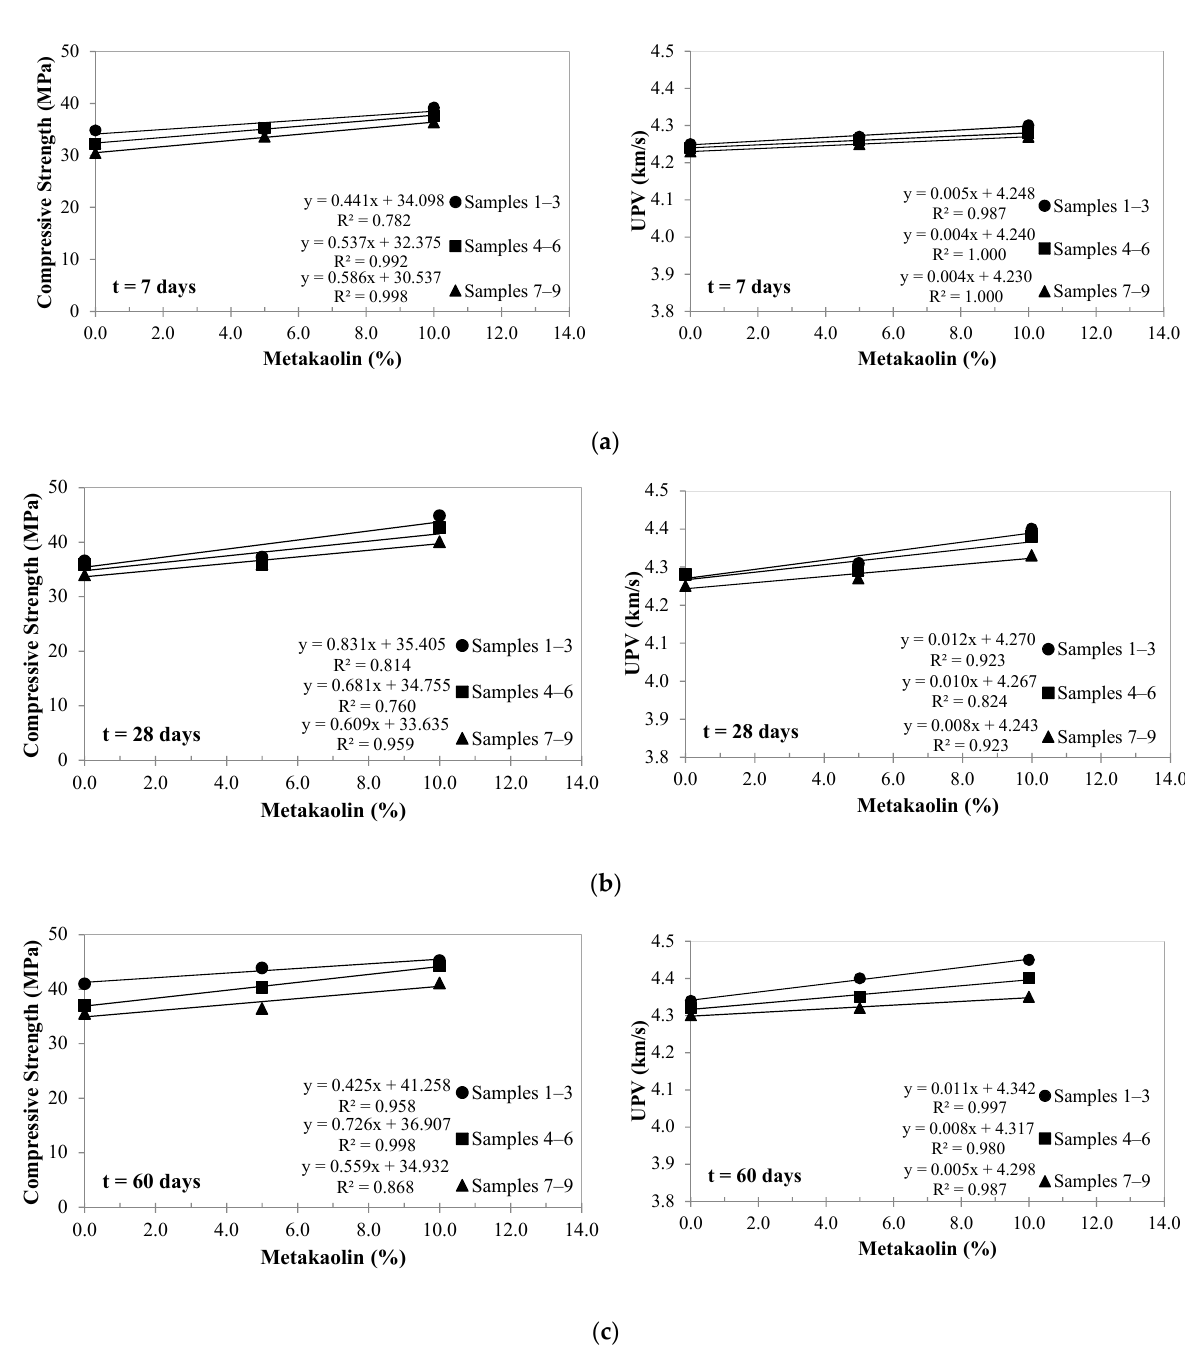
Figure 3. Influence of the metakaolin on concrete compressive strength and UPV, for ( a ) 7 days, ( b ) 28 days and ( c ) 60 days.